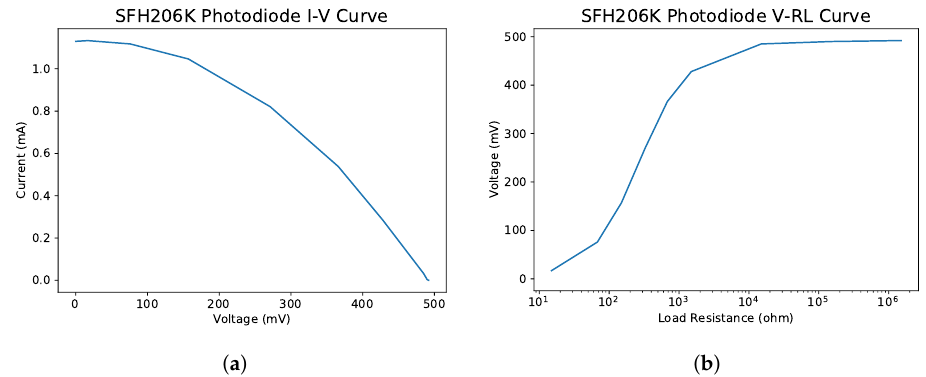
Figure 4. Measured DC curves of a SFH206K photodiode illuminated by a 5 mW laser at 2 cm. ( a ) The current-voltage relationship, with the maximum power point at the knee of the curve. ( b ) The relationship between output voltage and load resistance R L , which is relevant for driving the gate of a footer switch above its threshold.